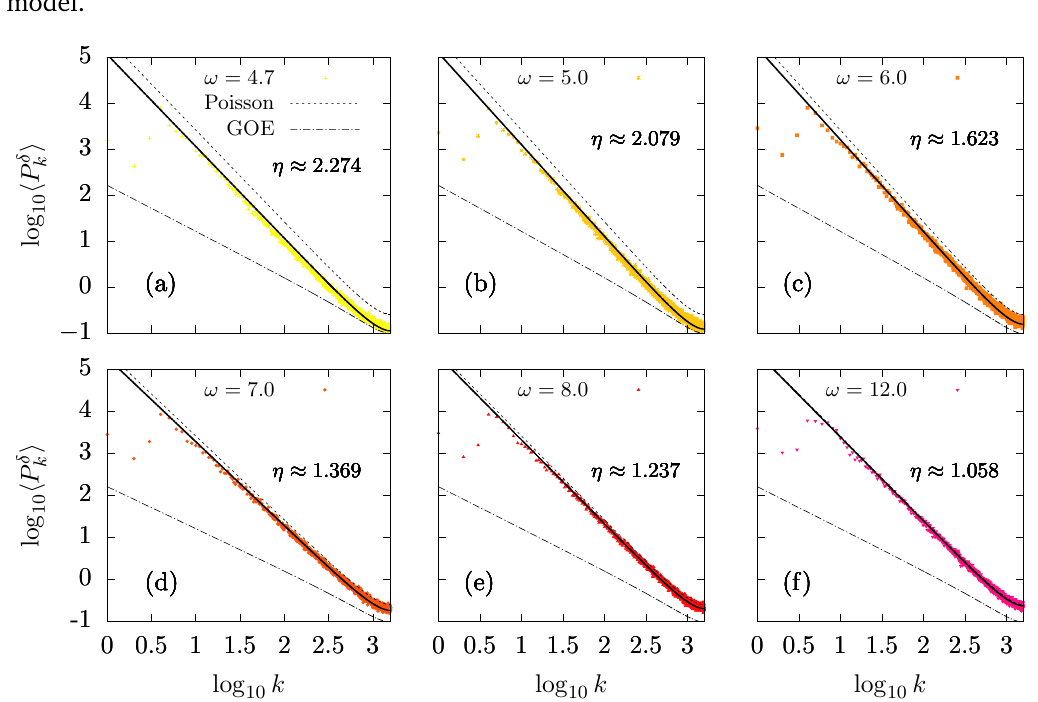
〉 , for the six values of disorder strength Figure 5: (a)-(f) Power spectrum of δ , 〈 P δ n k ω ∈ { 4.7,5.0,6.0,7.0,8.0,12.0 } (color points). Solid, black lines represent Eq. (12) for the values of η obtained from the NNSD, Fig. 4. Top and bottom dashed lines are the Poisson [ Eq. (12) with η = 1 ] and GOE results (see Ref. [ 88 ] ) respectively. Results correspond to L =